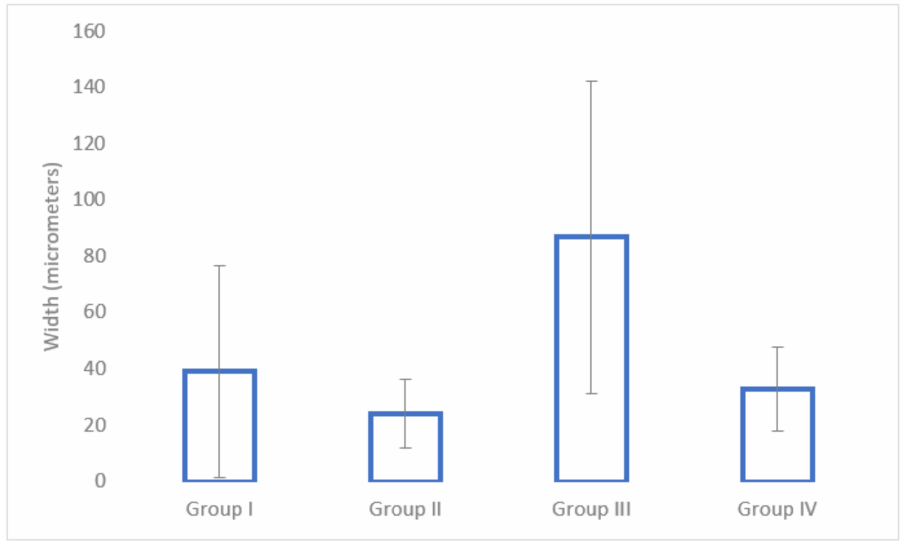
Figure 9. The average width of the fibrous tissue at the peri-implant